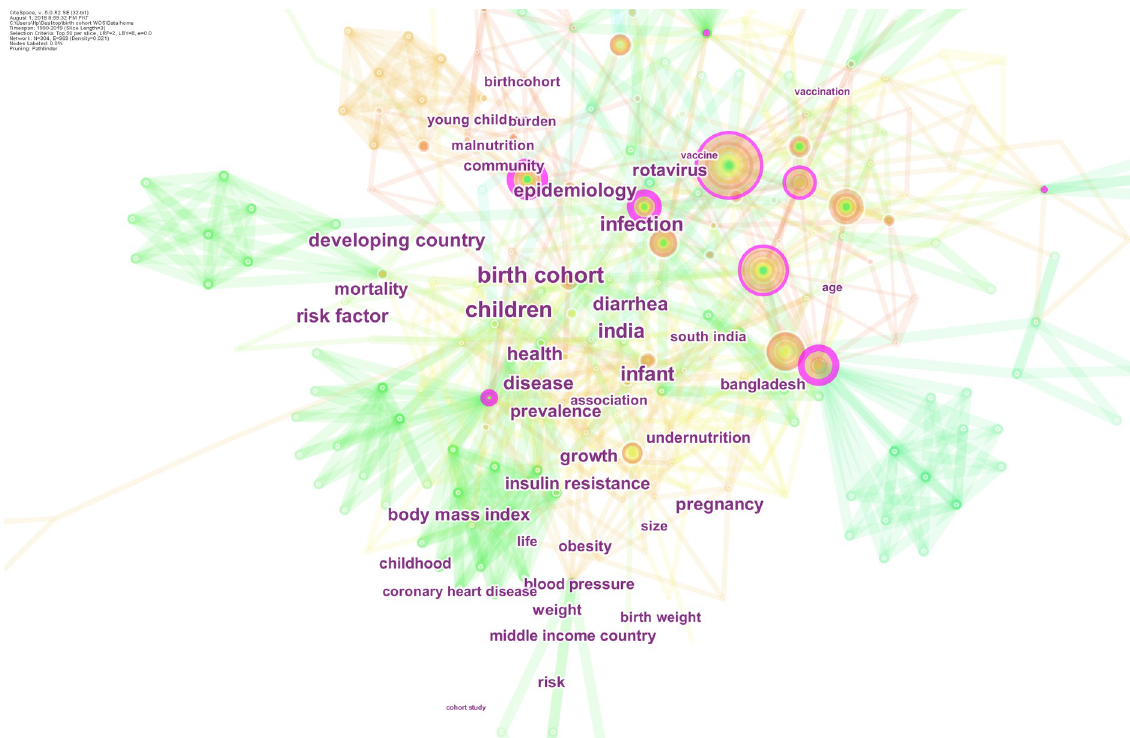
Fig 5. Top keywords mentioned in birth cohort related publications in South Asia. This figure presents top keywords used in birth cohort research in South Asia. Several important keywords attracting ground-breaking research are shown as purple rings, including infection, Bangladesh, Rotavirus, epidemiology and